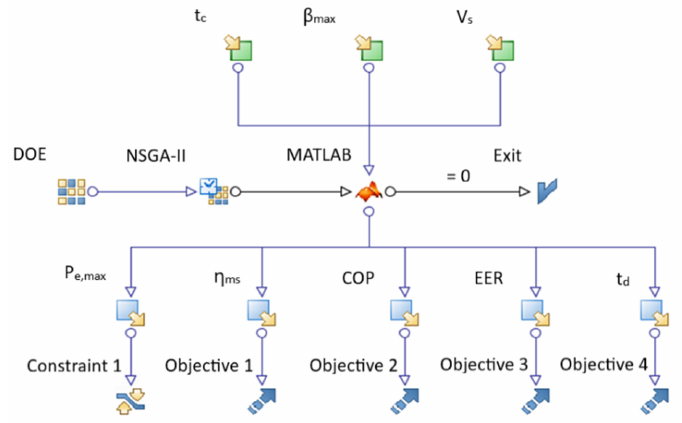
Figure 1. Workflow of the optimization problem on modeFRONTIER.